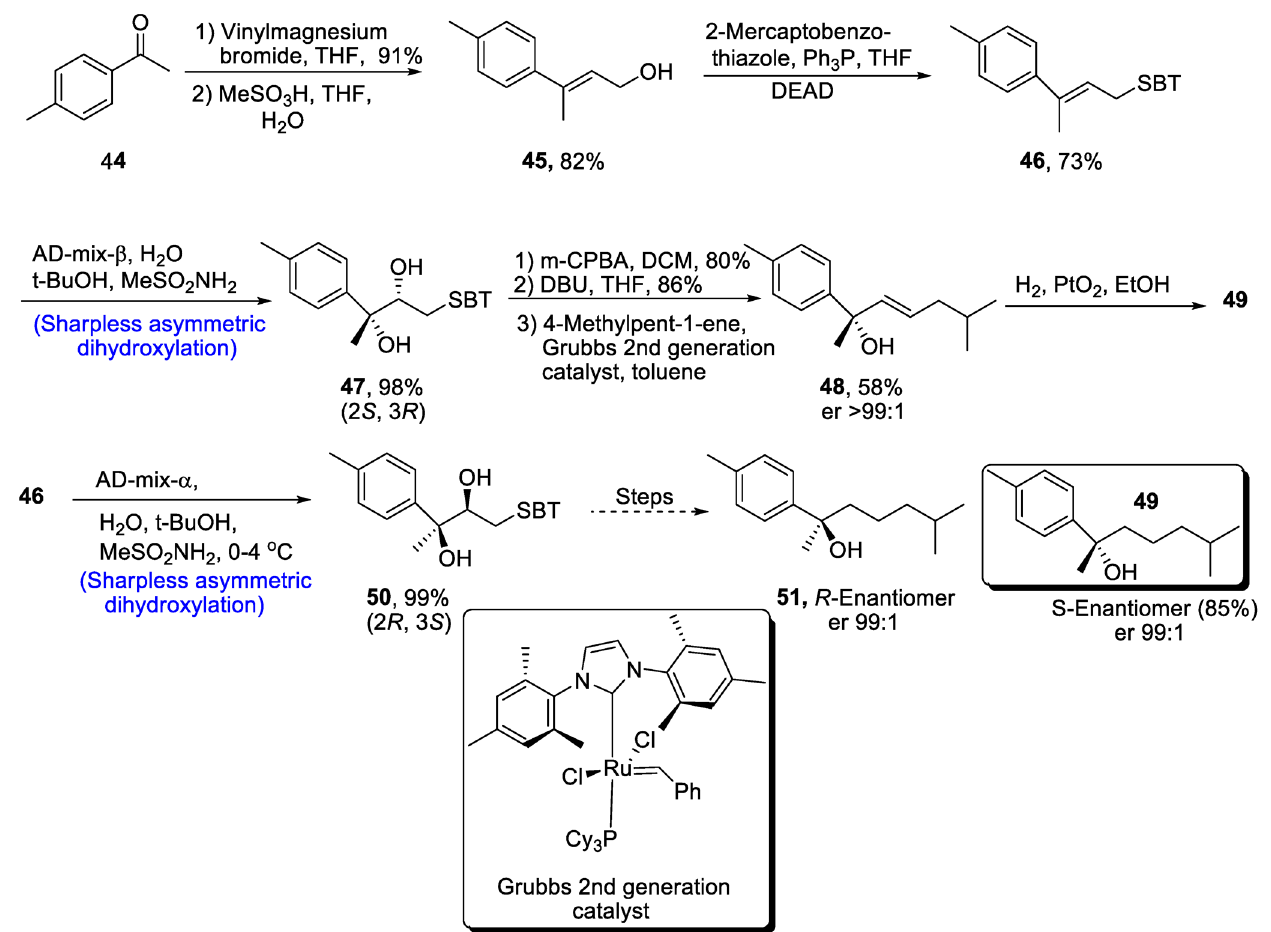
Scheme 8. Synthesis of aromatic bisabolanes 49 and 51